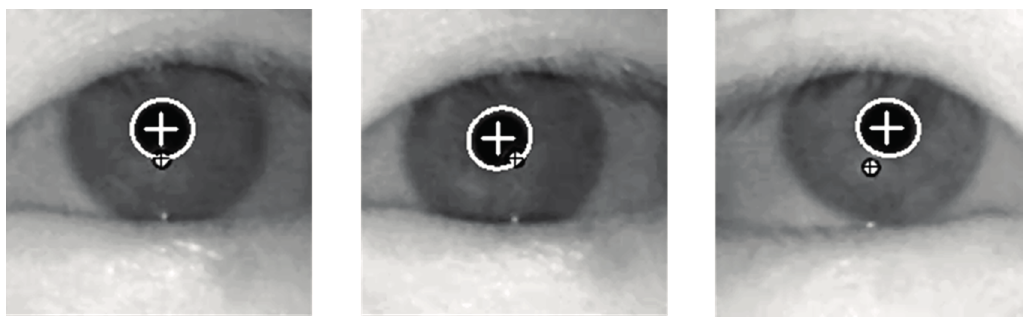
Figure 9. Binarized image using the local minima value as threshold.